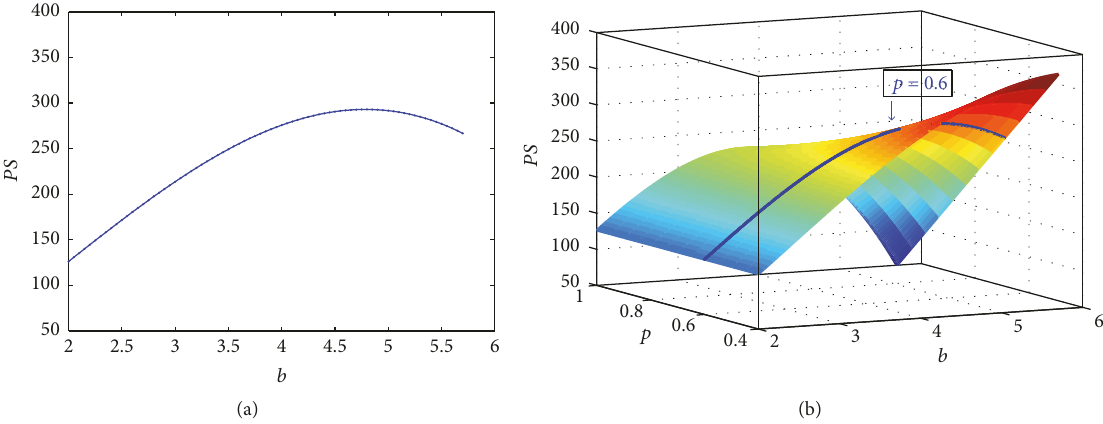
Figure 7: (a) The value of 𝑃𝑆(𝑏) (40) for 𝑝 = 0.6 and 𝑏 ∈ (2,5.7) ; (b) the value of 𝑃𝑆(𝑏) (40) for 𝑝 ∈ (0.4, 1) and 𝑏 ∈ (2,5.7) .